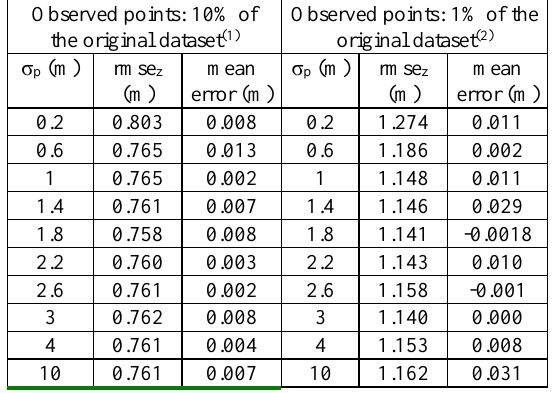
Figure 5. Vertical profile crossing one of the two dry ravines located at the working area. At the bottom, yellow points belong to the GMRF DSM while blue points are original LiDAR points